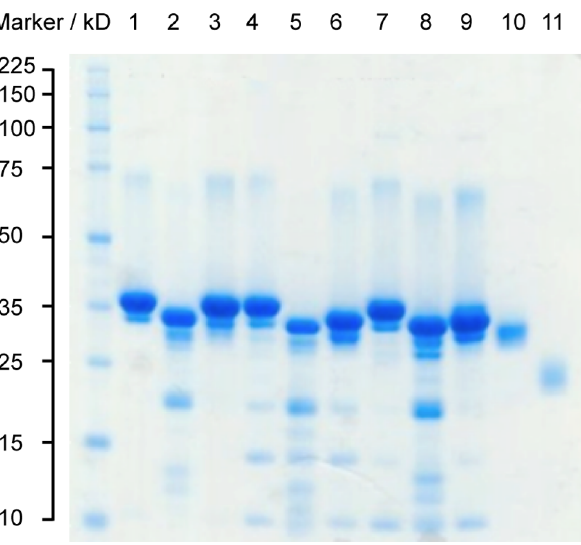
Figure 1. Thrombin specificity assay. Wild type and engineered CBG were incubated with thrombin. Only CBG-antitrypsin Pittsburgh and CBG-Thr349Arg were successfully cleaved by thrombin, while wild type CBG remained unreactive. Lane 1: wild type CBG (negative control); Lane 2: wild type CBG + human neutrophil elastase; Lane 3: wild type CBG + thrombin; Lane 4: CBG-antitrypsin Pittsburgh (negative control); Lane 5: CBG- antitrypsin Pittsburgh + human neutrophil elastase; Lane 6: CBG-antitrypsin Pittsburgh + thrombin; Lane 7: CBG- Thr349Arg (negative control); Lane 8: CBG-Thr349Arg + human neutrophil elastase; Lane 9: